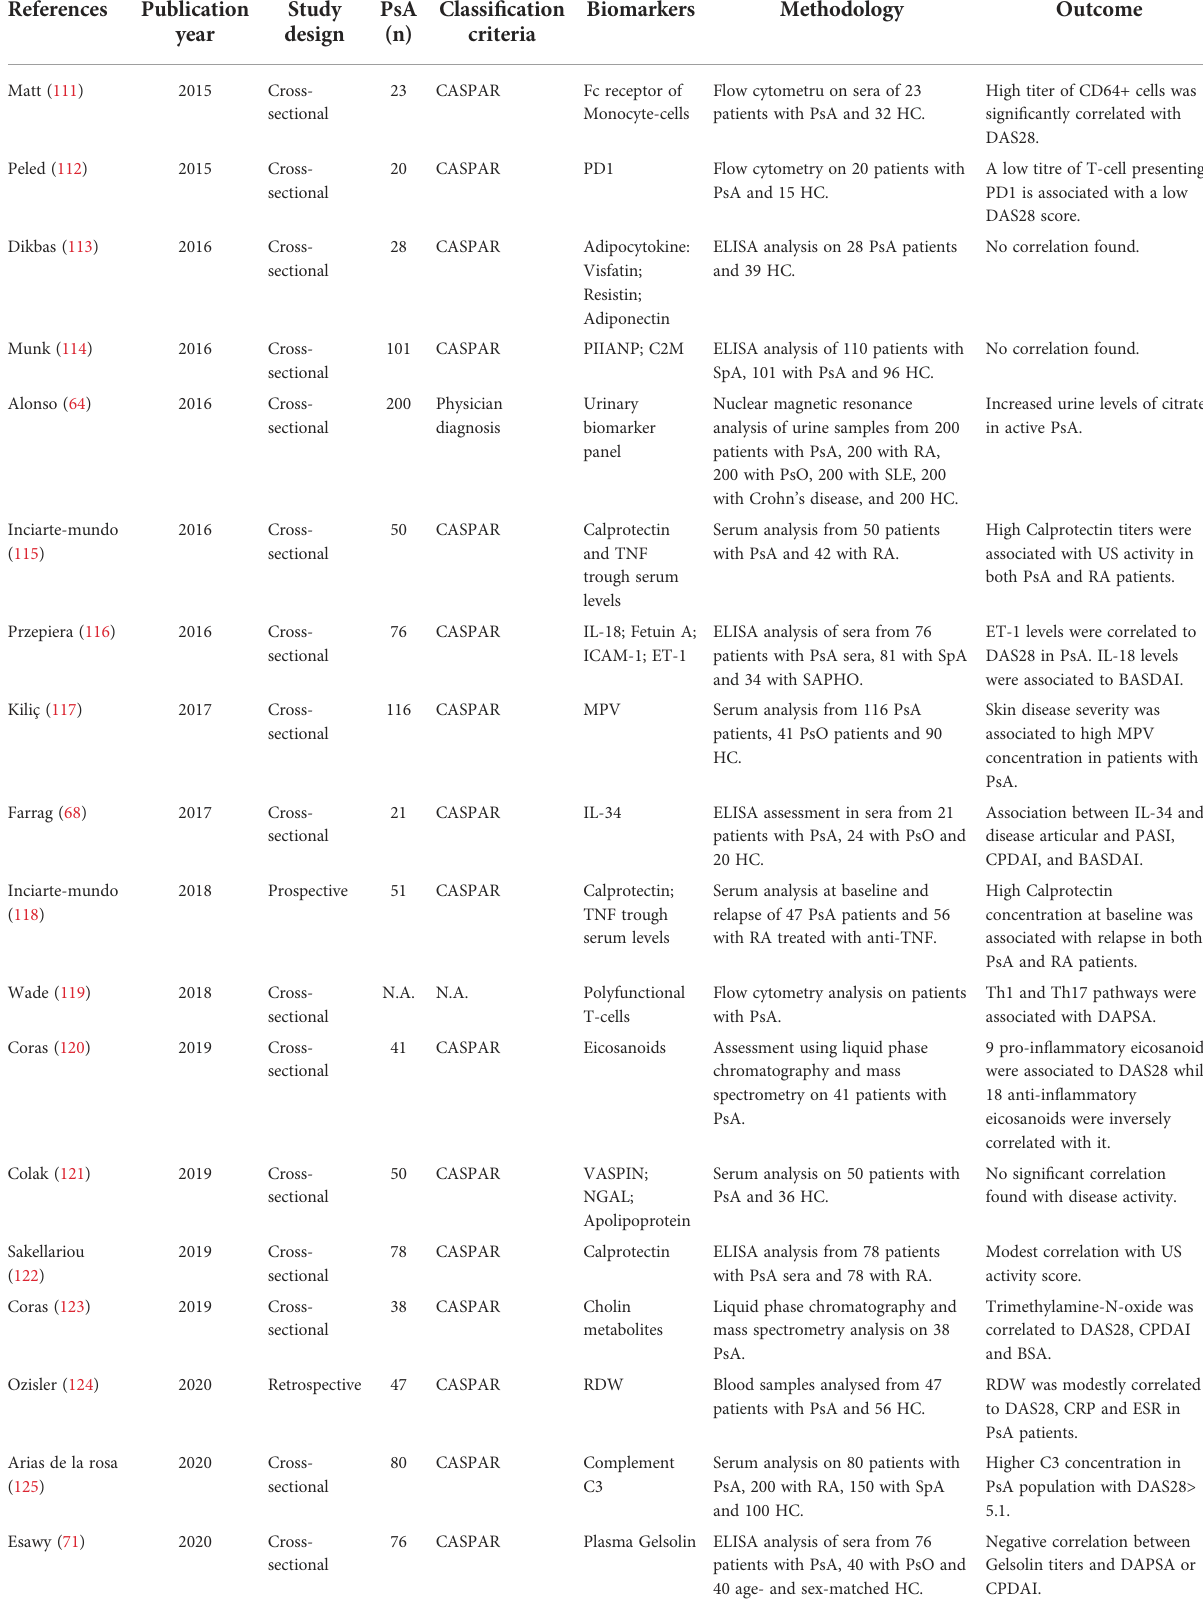
Flow cytometry on 20 patients with PsA and 15 HC.